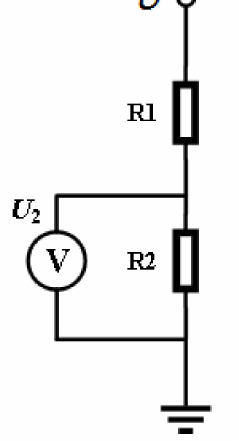
Figure 2. Schematic diagram of resistor